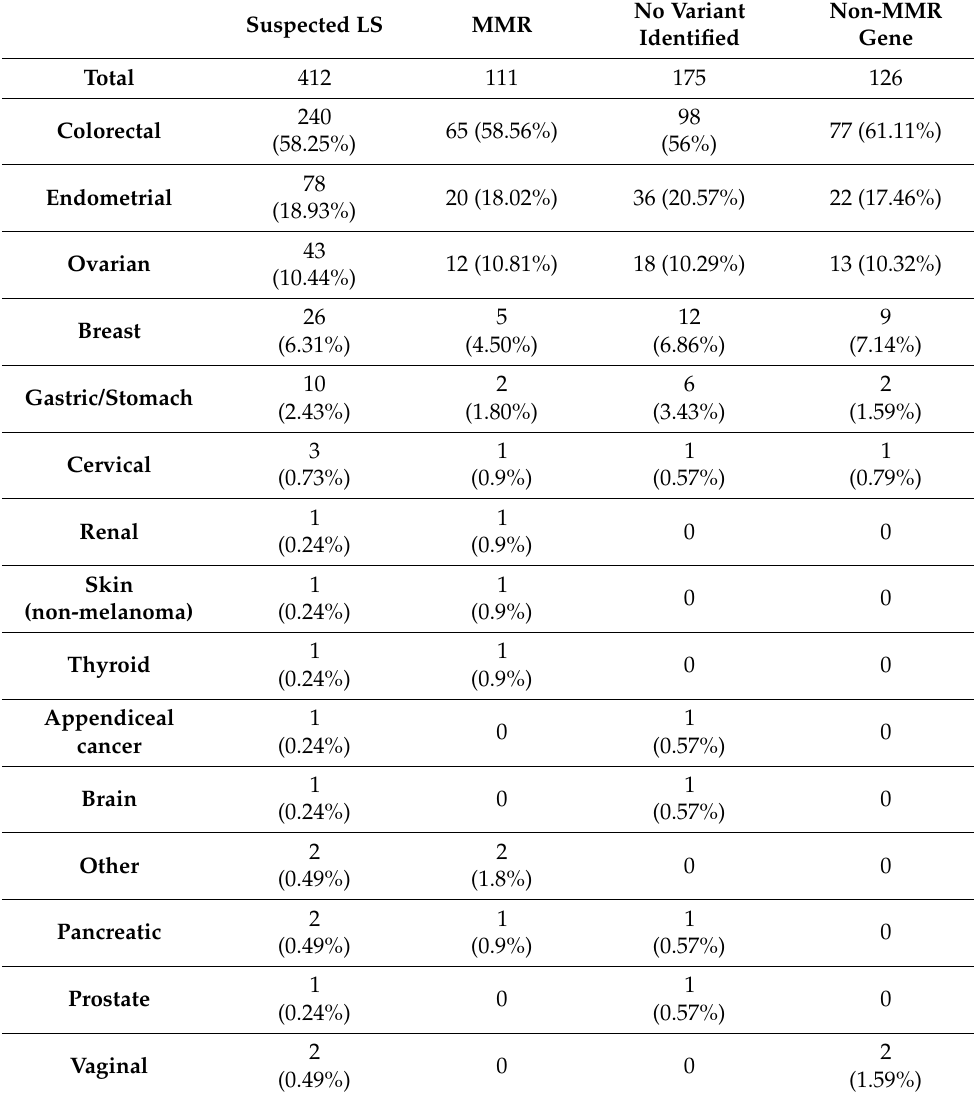
Table 2. Type of diagnosed cancer in patients with suspected Lynch syndrome, with MMR variants, no variant identified, and with variants in other genes.